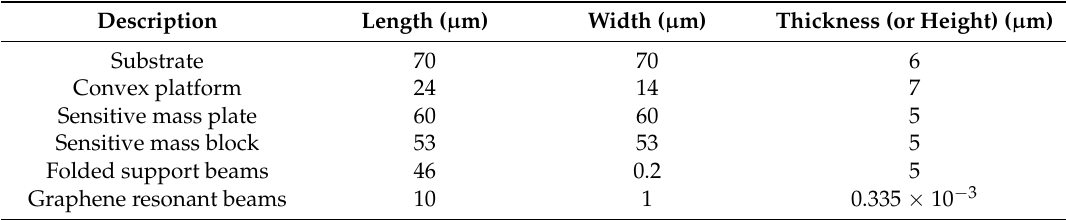
Table 1. Initial structural parameters for the graphene accelerometer.